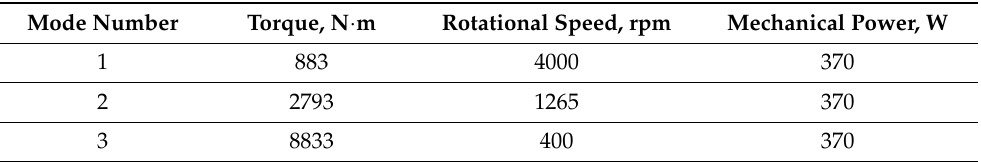
Table 1. Operating points of the traction SHM considered during the optimization.